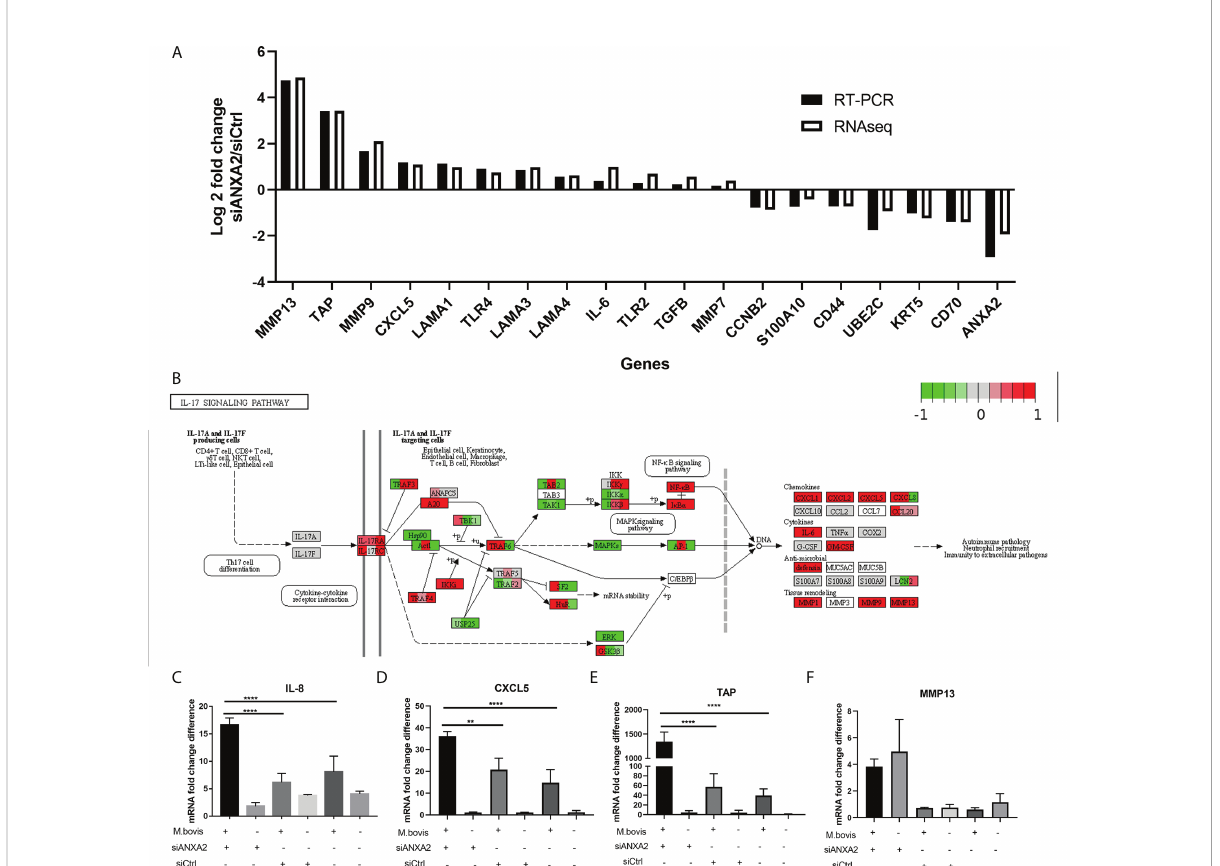
FIGURE 7 Validation of expression patterns of selected genes using qPCR. (A) Log2 Fold changes of mRNA expression levels of 19 DEGs encoding in fl ammation- related chemokines and cytokines, as well as other randomly selected DEGs by qPCR in M. bovis infected EBL cells with or without siANXA2 transfection. (B) Validation of DEGs associated with the IL-17 signal pathway in M. bovis -infected EBL cells treated with siANXA2 and siCtrl. The DEGs were mapped to IL-17 signaling pathway. The fi lled red and green color represents upregulated and downregulated genes respectively. (C – F) . qRT-PCR validation of DEGs IL-8 (C) , CXCL5 (D) , TAP (E) and MMP13 (F) genes mapped in the IL-17 signaling pathway in M. bovis infected or uninfected cells treated with siANXA2 and siCtrl. The values shown in the graphs are the mean ± SD of three independent experiments. ** represents p < 0.01, and **** represents p <